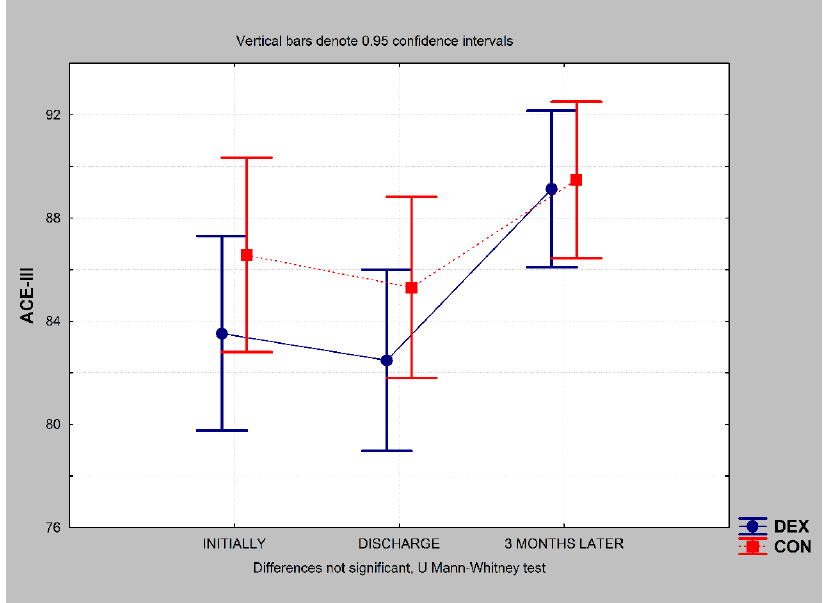
Figure 5. Addenbrooke’s Cognitive Examination version III (ACE-III) results in the DEX and CON groups. CON, control; DEX, dexmedetomidine; Min, minimum; Max, maximum. groups. CON, control; DEX, dexmedetomidine; Min, minimum; Max, maximum.